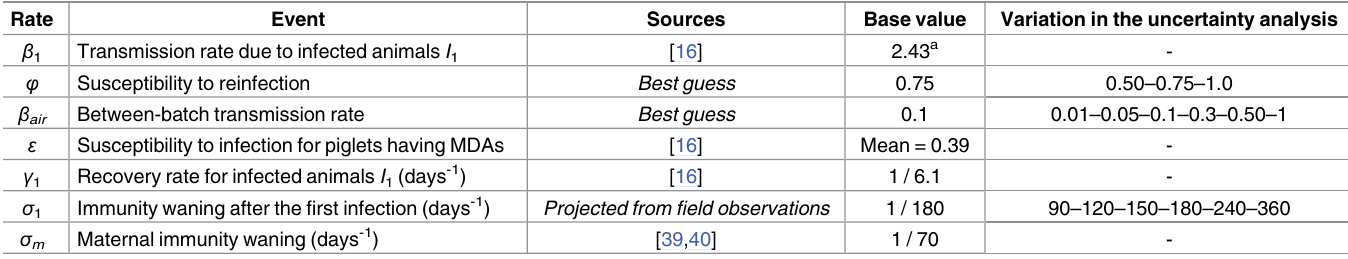
Table 2. Parameter values used in the swIAV infection dynamics